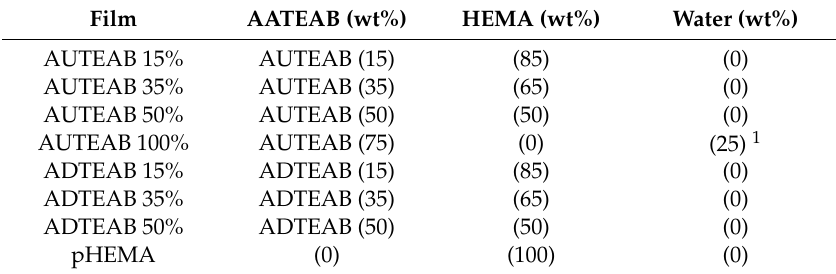
Table 1. Relative amounts of the components used for preparing the polymeric